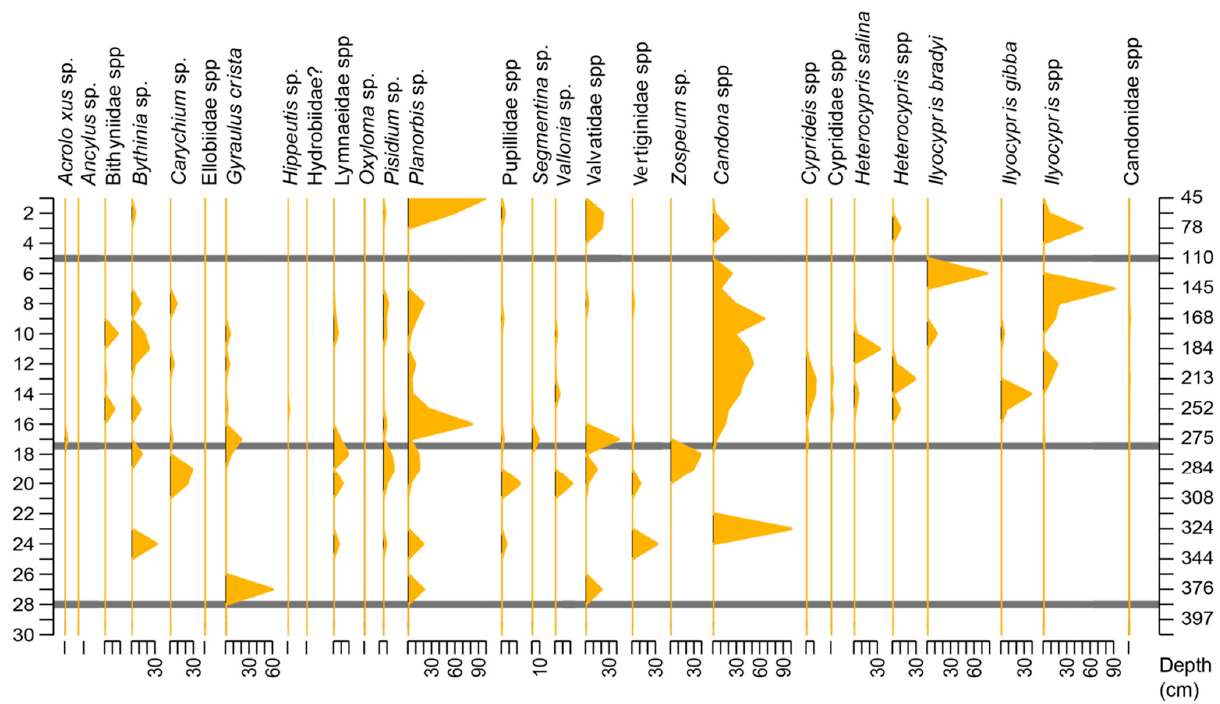
Figure 4. Stratigraphic plot for ALM3, mollusc and ostracod taxa. The horizontal grey lines indicate the limits of molluscan–ostracod units.